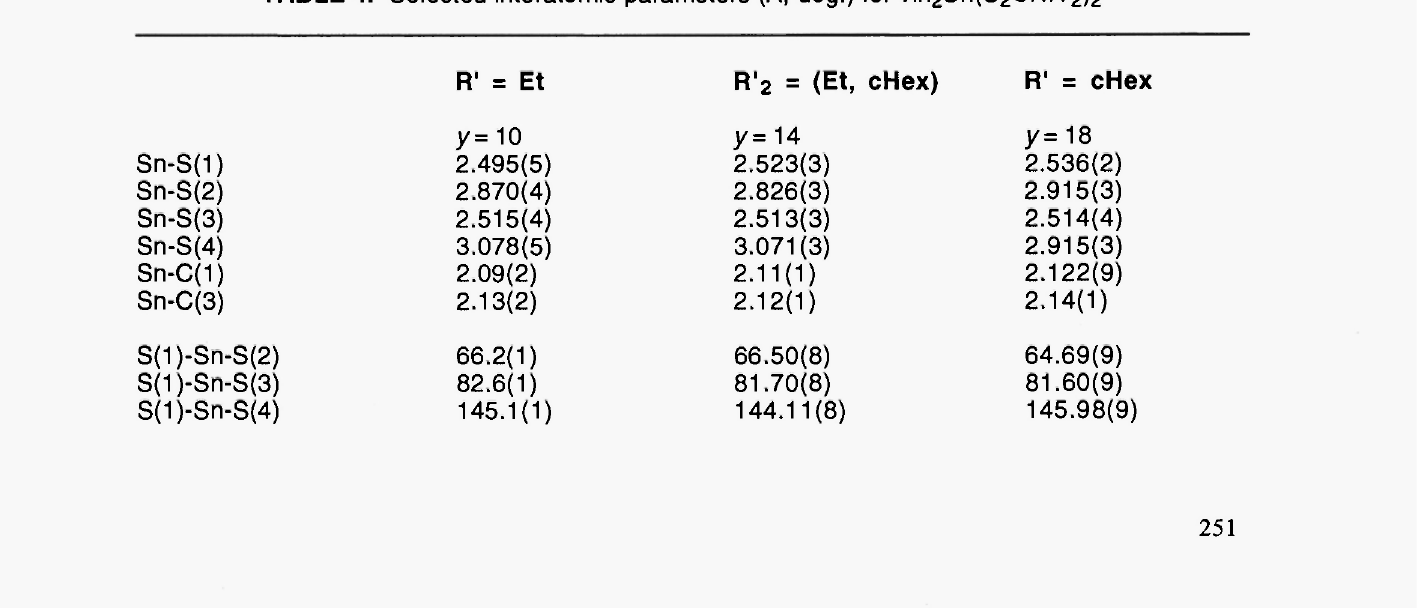
TABLE 4. Selected interatomic parameters (A, deg.) for vin 2 Sn(S 2 CNR' 2 )